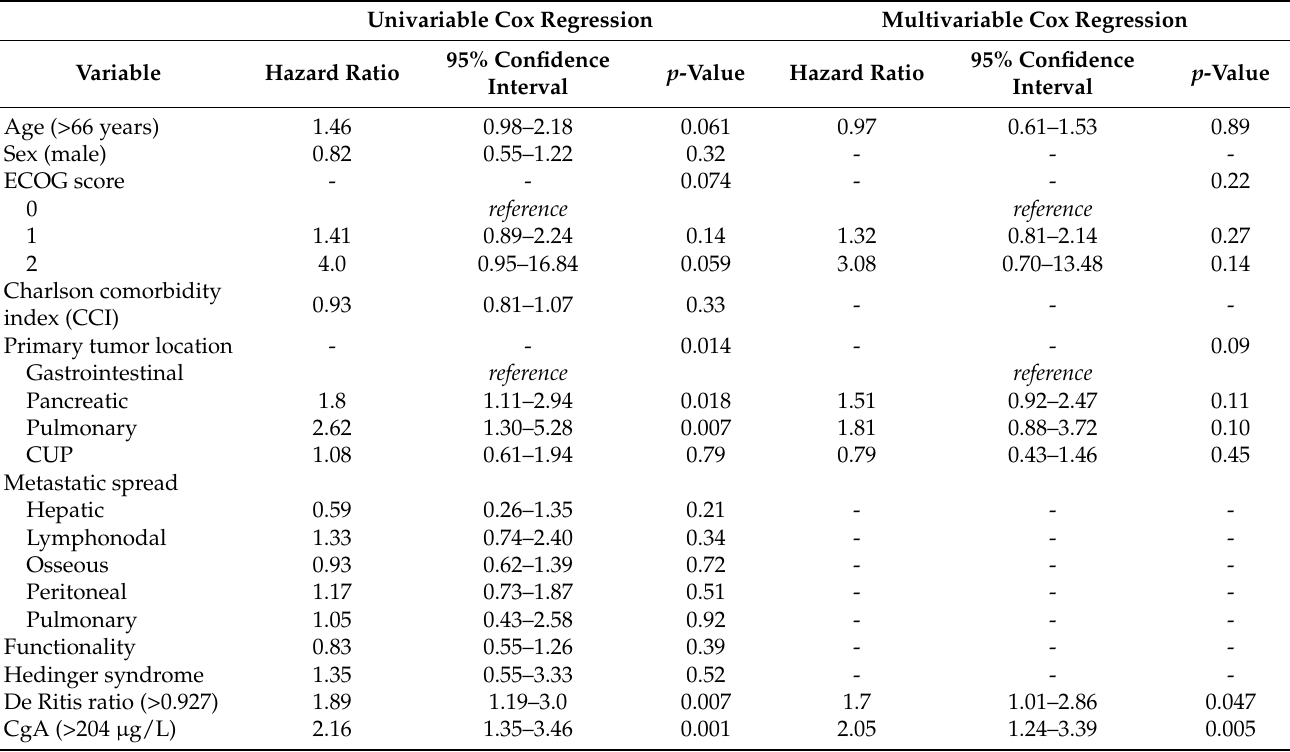
Table 2. Univariable and multivariable Cox regression.